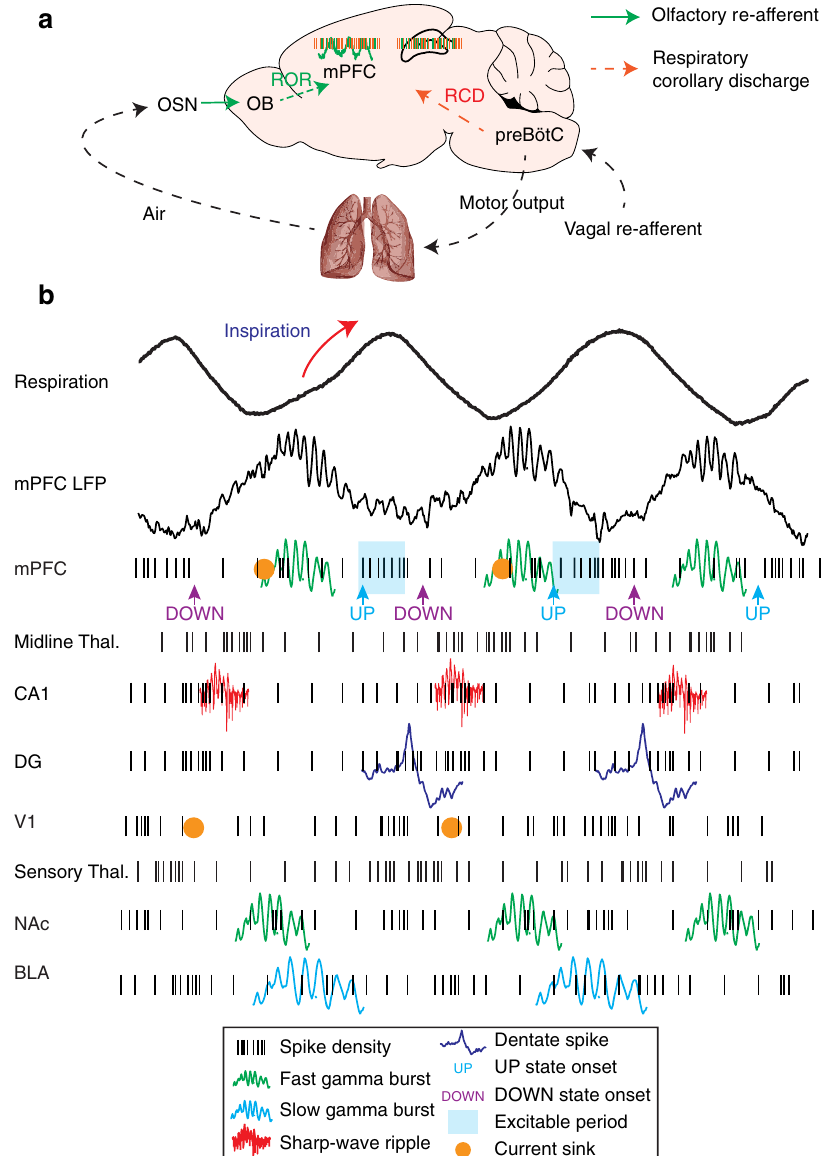
Fig. 10 Breathing organizes network dynamics across limbic structures. a Schematic depiction of the efferent copy pathway carrying the respiratory corollary discharge (RCD) signal and the reafferent pathway carrying the respiratory olfactory reafferent (ROR) signal. b Summary schematic of the network dynamics organized by breathing throughout all structures studied. Black traces: LFPs; Black ticks: neuronal spikes; Green traces: Fast (~80 Hz) gamma; Cyan traces: Slow gamma (~40 Hz); Red traces: CA1 Ripples; Blue traces: Dentate spikes; Orange dots: CSD sinks (mPFC deep layers, V1 LGN input, and DG middle molecular layer); Blue shadow: Cortical excitability Consistent with such mechanism, the optogenetic induction of 4 Hz oscillations in prefrontal circuits is suf fi cient to drive fear behavior in naïve animal 30 , raising the possibility that this effect is mediated by the bidirectional interaction of prefrontal networks with the respiratory centers via top-down projections to periaqueductal gray and the ascending feedback via RCD giving rise to system-level resonance at breathing frequency. This sets the stage for future investigations of the interaction between the RCD and ROR in limbic networks and, in turn, the top-down modulation of breathing and emotional responses.